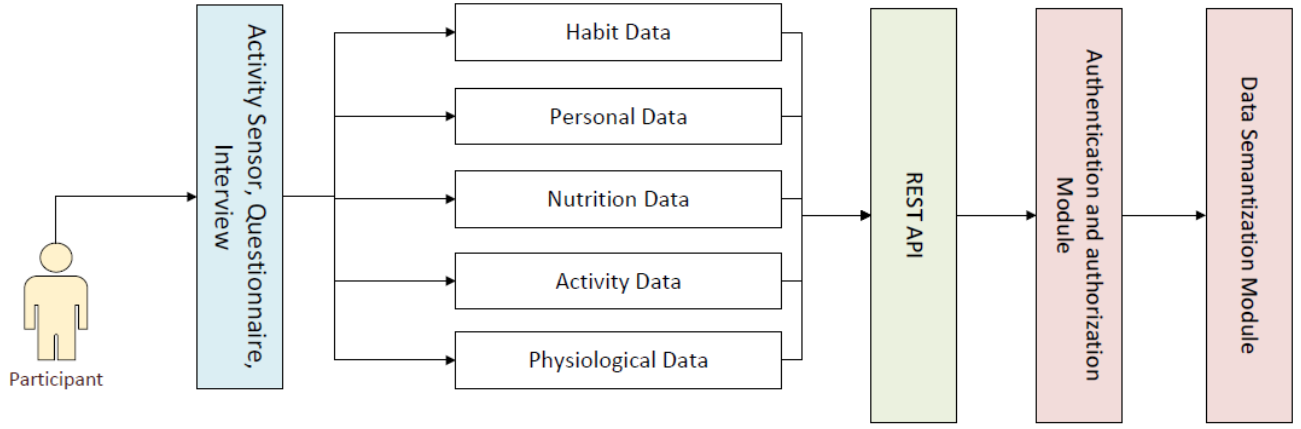
Figure 1. The modules of the eCoach prototype system.